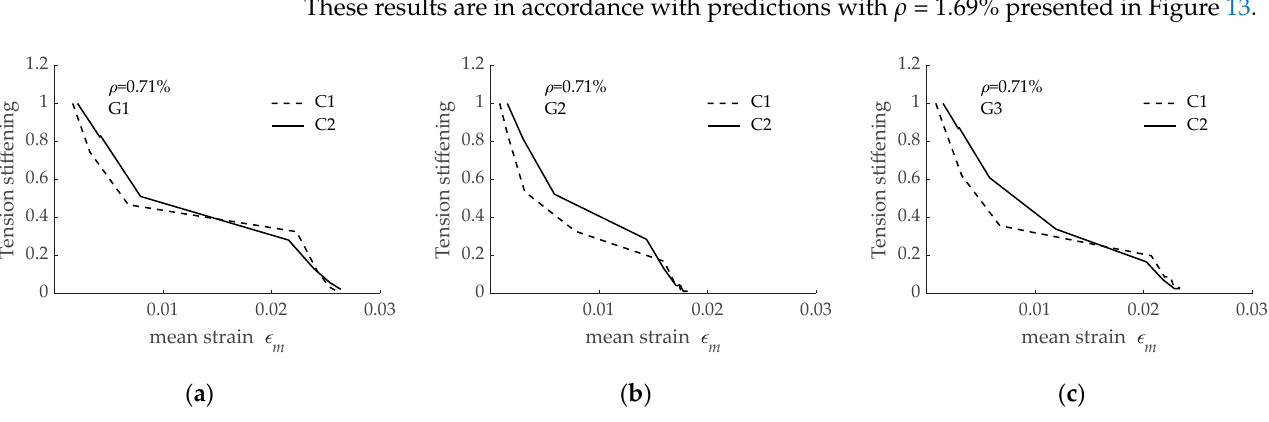
Figure 15. Effect of concrete compressive strength on tension stiffening effect for RC tensile elements ( ρ = 0.71%) reinforced with: ( a ) G1 bar; ( b ) G2 bar; ( c ) G3